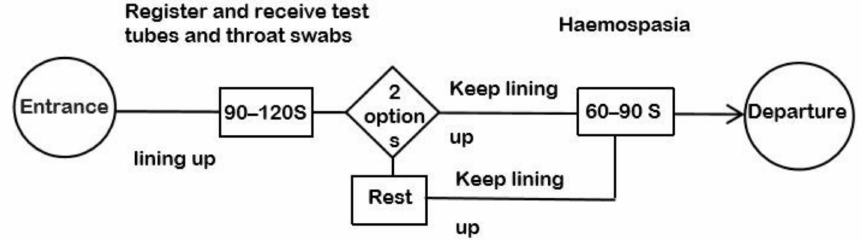
Figure 5. Community virus-testing workflow in the late COVID-19 pandemic